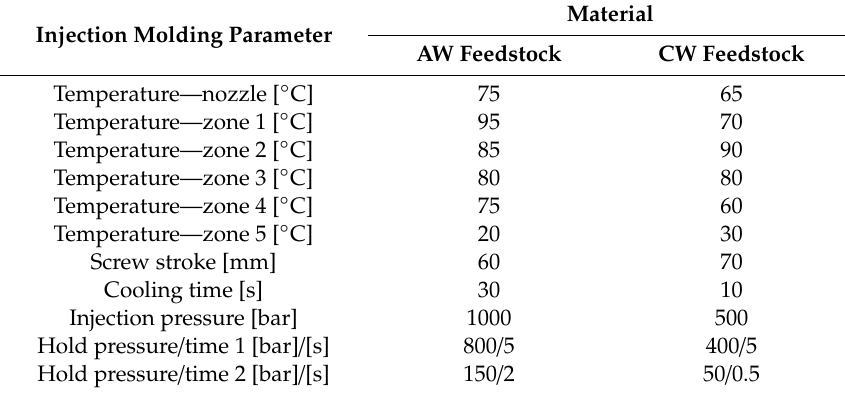
Table 1. Injection molding conditions for AW- and CW-based feedstocks.